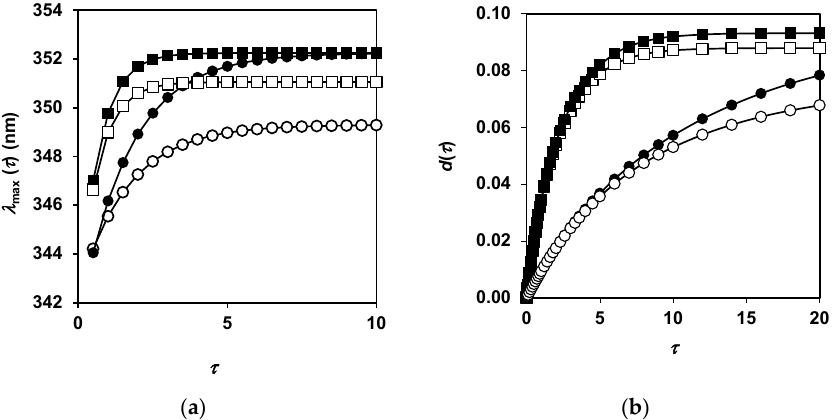
Figure 4. Numerical simulation of proteolysis process according to proposed model: ( a ) expected dependences of the fluorescence maximum on the dimensionless time τ at ε = 5 for κ m = 0 ( ■ ) and 0.01 ( □ ), and at ε = 2.1 for κ m = 0 ( ● ) and 0.01 ( ○ ); ( b ) expected dependences of the hydrolysis degree on the dimensionless time at ε = 2 for κ m = 0 ( ■ ) and 0.05 ( □ ), and at ε = 0.4 for κ m = 0 ( ● ) and 0.05 ( ○ ).